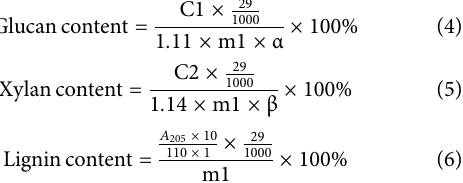
Batch Enzyme feeding TSW feeding Enzyme and TSW